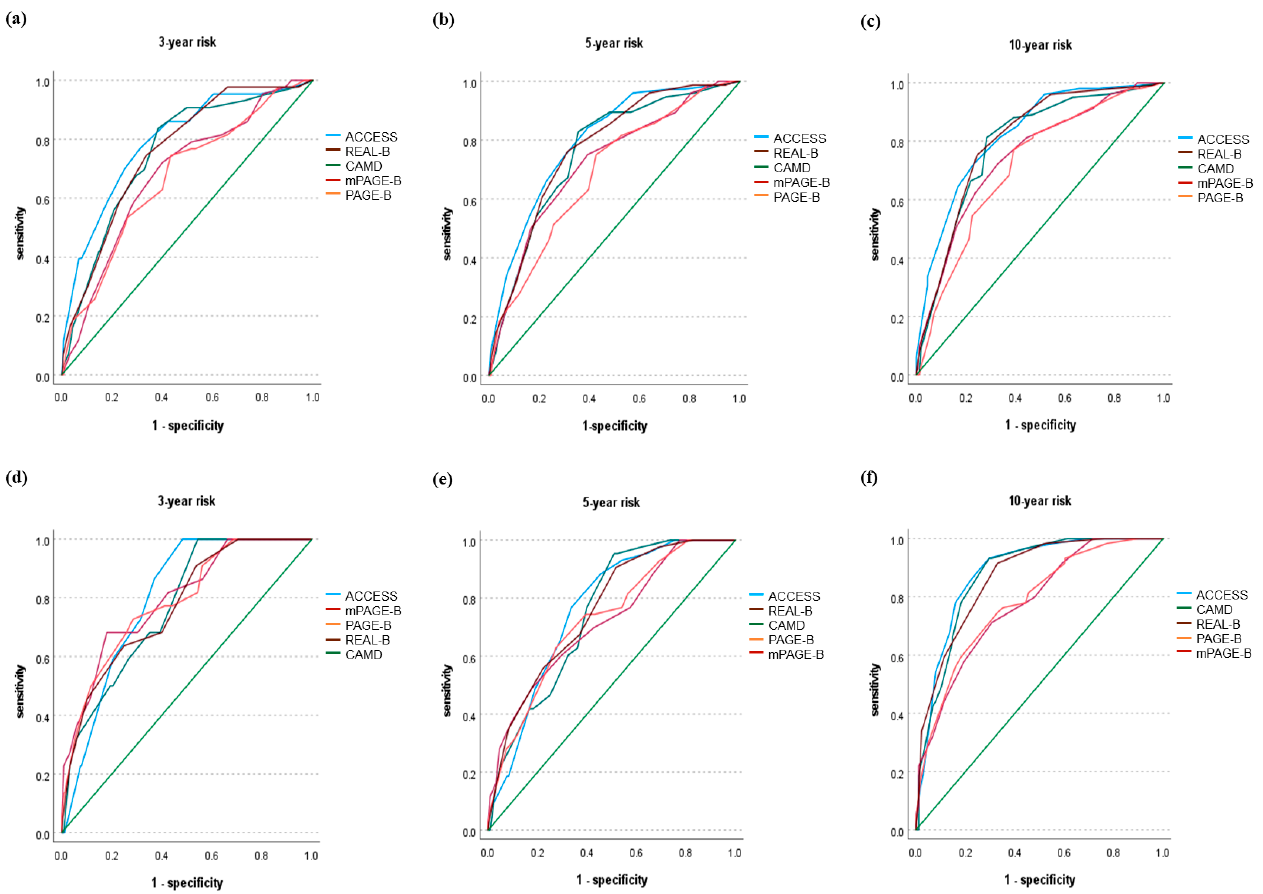
Figure 1. This is a figure Comparison of the AUROC in the ACCESS-HCC prediction model and the existing models from derivation cohort & validation cohort: ( a ) 3-year risk, ( b ) 5-year risk, ( c ) 10- year risk from derivation cohort; ( d ) 3-year risk, ( e ) 5-year risk, ( f ) 10-year risk from validation cohort. Table 4. Areas under the ROC Curves for predicting the 3-, 5-, and 10-year hepatocellular carcinoma risk using ACCESS and other scores in the validation cohort ( n =